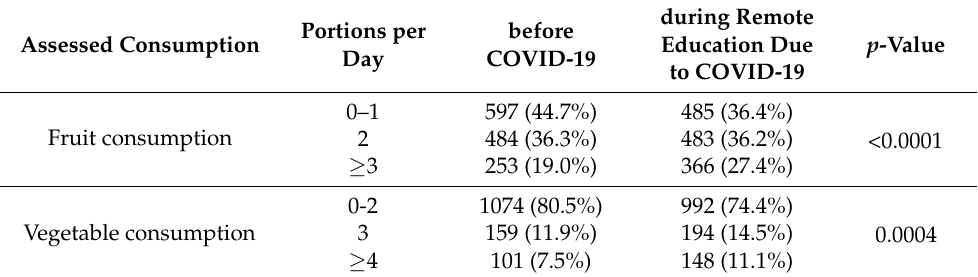
Table 2. Analysis of declared fruit and vegetable consumption in the studied group of Polish adolescents within the Diet and Activity of Youth during COVID-19 (DAY-19) Study.